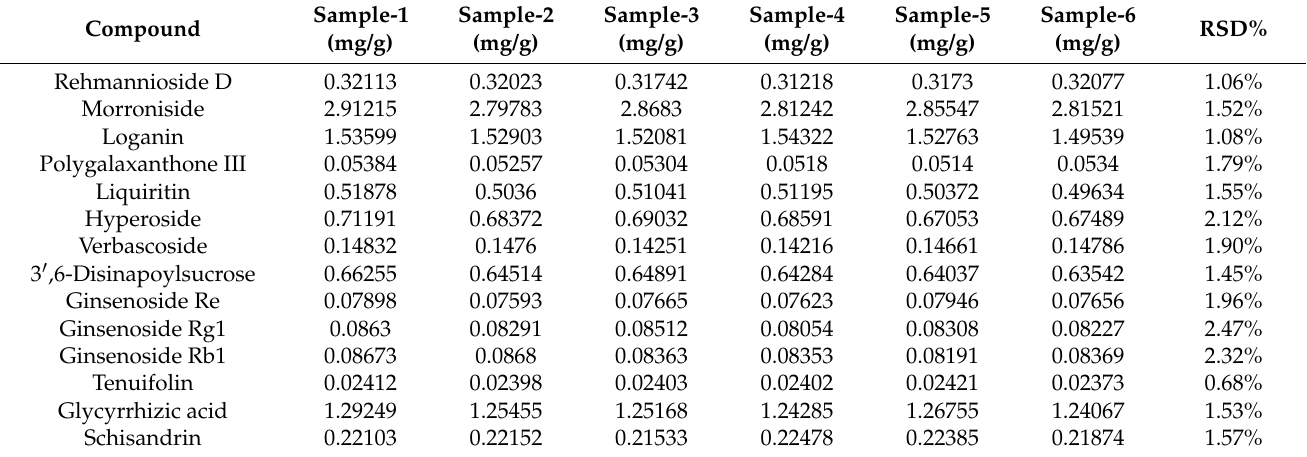
Table 4. Repeatability study results of 14 analytes.